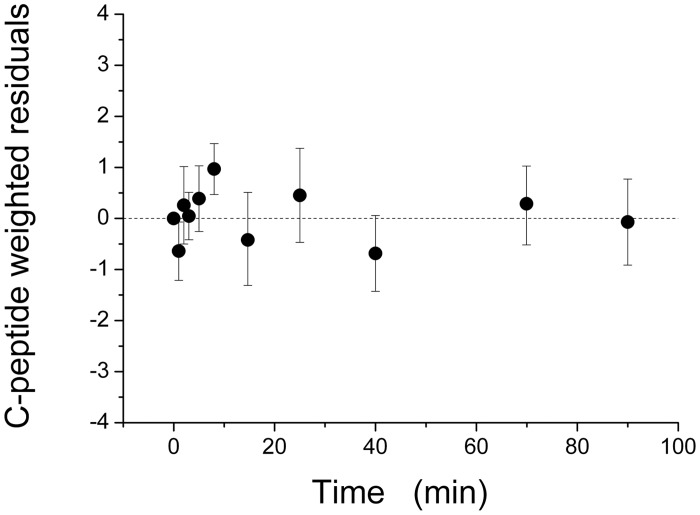
Mean (±SD) weighted residual over all our fourteen Zucker rats (7 ZFRs and 7 ZLRs) provided by fitting the CPMM output to C-peptide data.